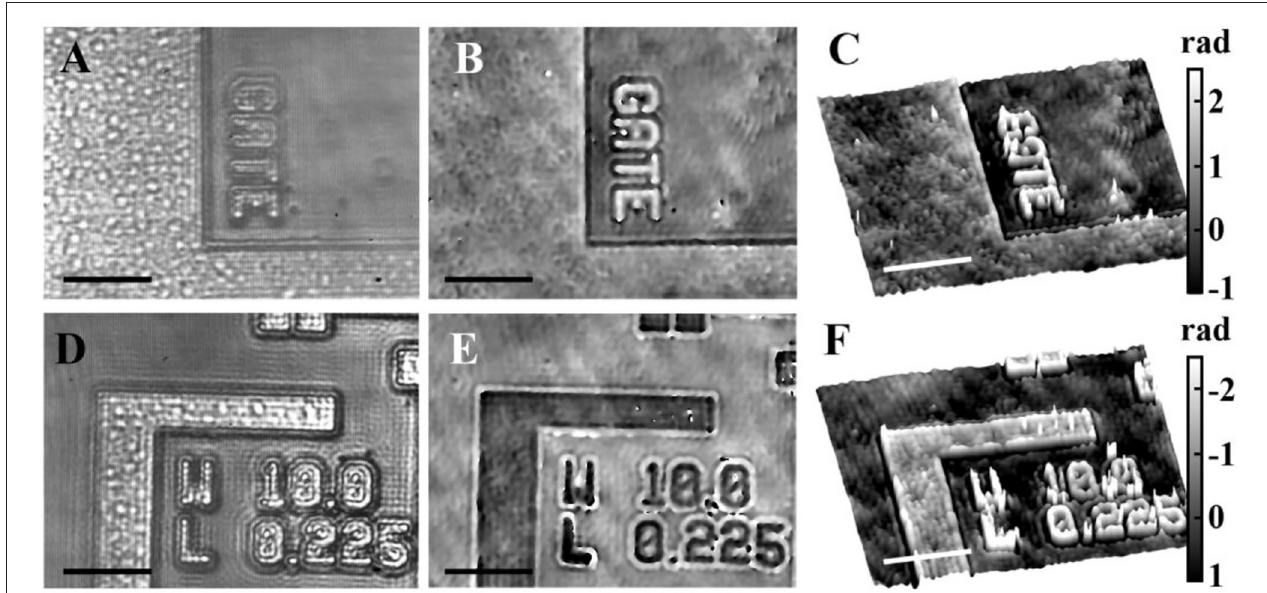
FIGURE 3 | Inspection of a microchip silicon wafer using SER-DHM. (A,D) Off-axis digital holograms involving two different areas. (B,E) Retrieved phase distributions. (C,F) 3D phase distributions. Scale bars in images are 20 µ